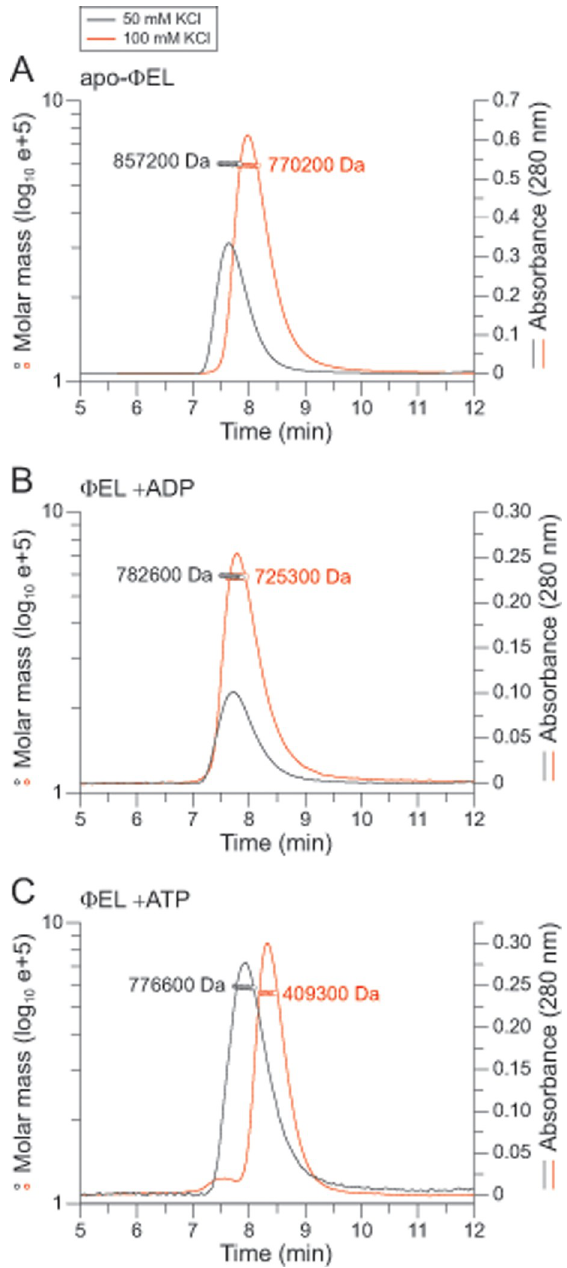
Fig 1. Oligomeric state of ɸ EL in solution. (A-C) SEC-MALS analysis of F EL in absence of nucleotide (A), in presence of 2 mM ADP (B) or 2 mM ATP (C). The chromatographic absorbance traces at 280 nm wavelength are shown. The molecular mass determined for the protein peaks by static light scattering is indicated. The black and red traces were recorded in presence of 50 and 100 mM salt, respectively.